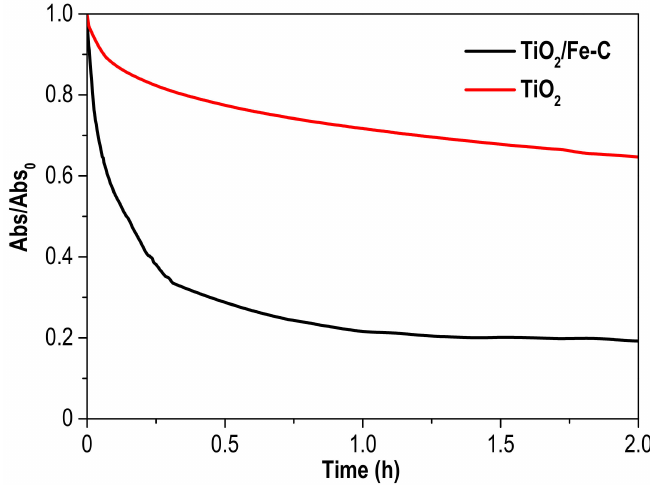
Figure 7. Absorbance evolution profiles (600 nm) during settling test of TiO 2 /Fe-C and TiO 2